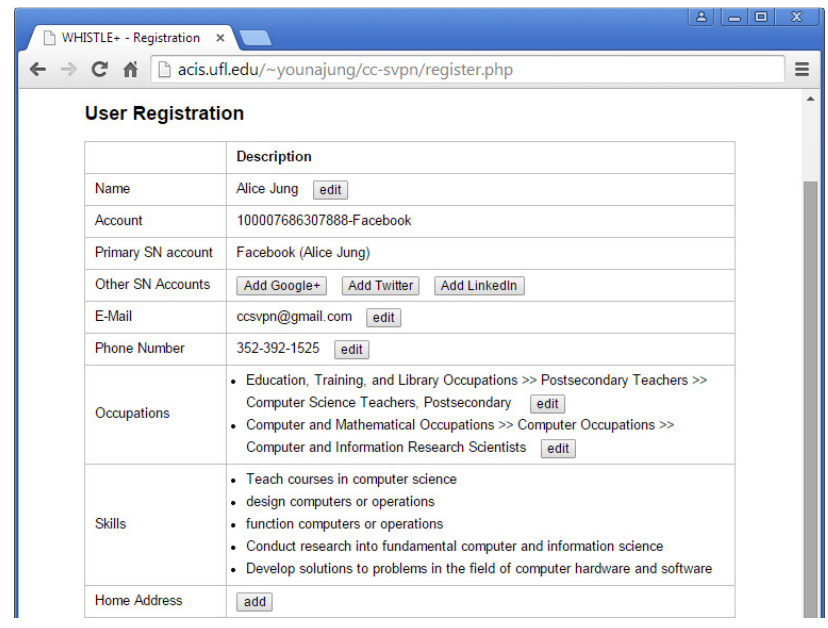
Figure 10. A community request made by Alice to find a missing daughter lost in the ‘Toys R Us’ store